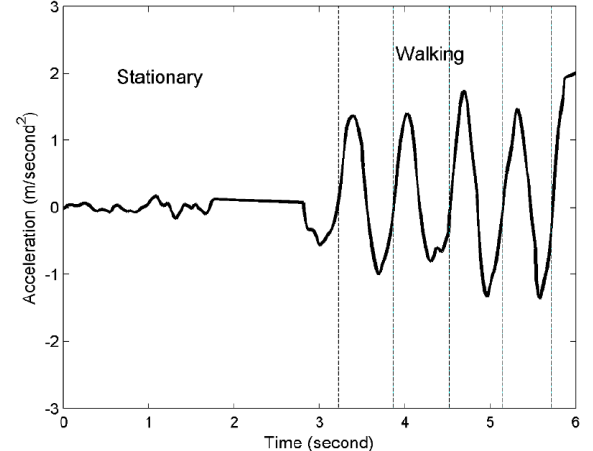
Figure 2. The acceleration patterns of a pedestrian in stationary and walking